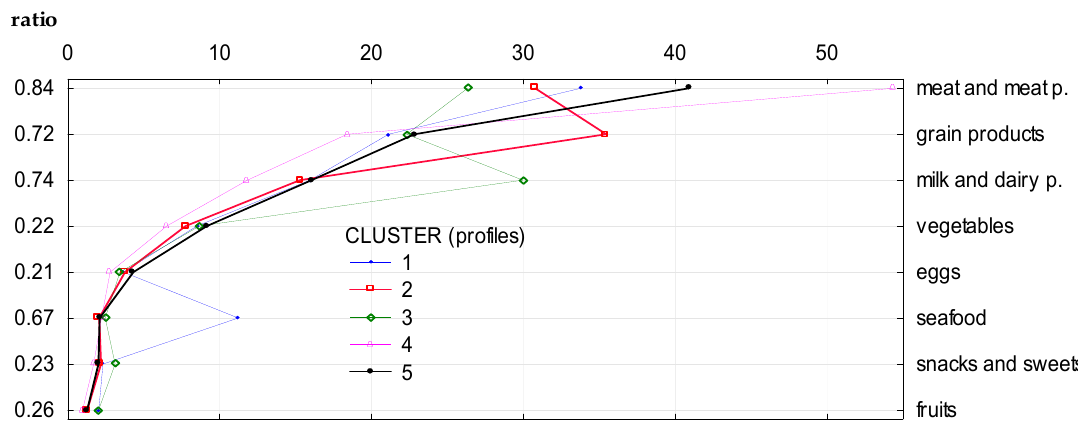
Figure 1. Cluster analysis of population sample in relation to the food categories contribution to total protein supply. p.—products.